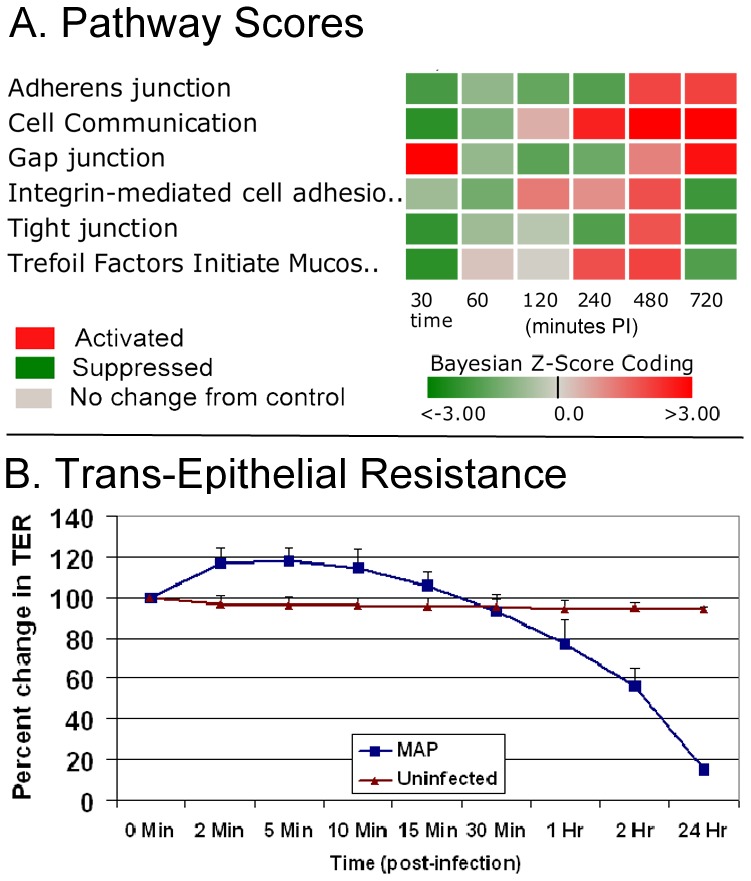
Pathway Scores for Cell Communication and Cell Adhesion Pathways and their Involvement in Trans-Epithelial Resistance (TER).The set of genes within the gap junction, tight junction, adherens junction and integrin-mediated cell adhesion are contained in the cell communication pathway. (3a). Pathway scores for Adherens Junction (AJ), Cell Communication (CC), Gap Junction (GJ), Integrin-mediated Cell Adhesion (IMCA), Tight Junction (TJ) and Trefoil Factors Initiated Mucosal Healing (TFIMH). Red indicates an activated state while green indicates suppression. Note the reversal of the cell communication pathway from suppressed to activated from the Phase 1 (30–60 min.) to the Phase 3 time period (720 min.). (3b). Changes in the Trans-Epithelial Resistance of polarized T-84 cells exposed to MAP for 24 h. Data represent mean ± SD from 3 measurements at each time point and three independent experiments.